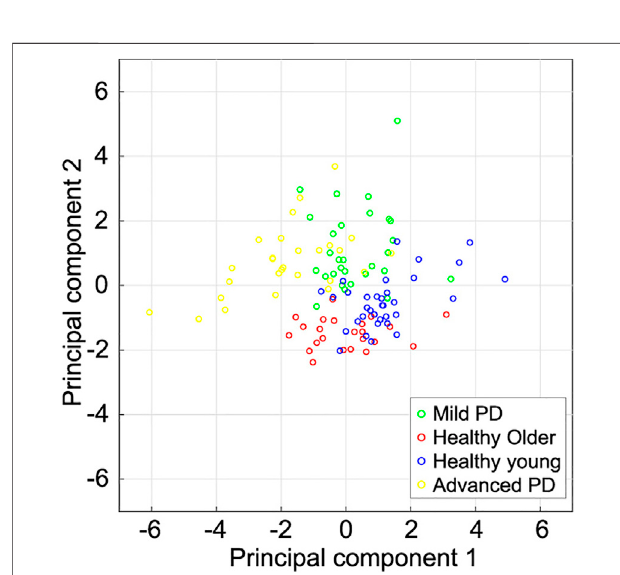
FIGURE 5 | Scatter plot of the fi rst two principal components extracted from subjects ’ spatial gait features. The fi rst and second component magnitudes representthe displacementsofthe foot trajectories inthe forward and vertical directions, respectively. Healthy young individuals tended to have a larger fi rst principal component than other subjects. The fi rst principal component ofmild PD patients and healthy older individuals islarger than that of advanced PD patients. The second principal component of healthy older individuals tends to be smaller than that of the other subjects.